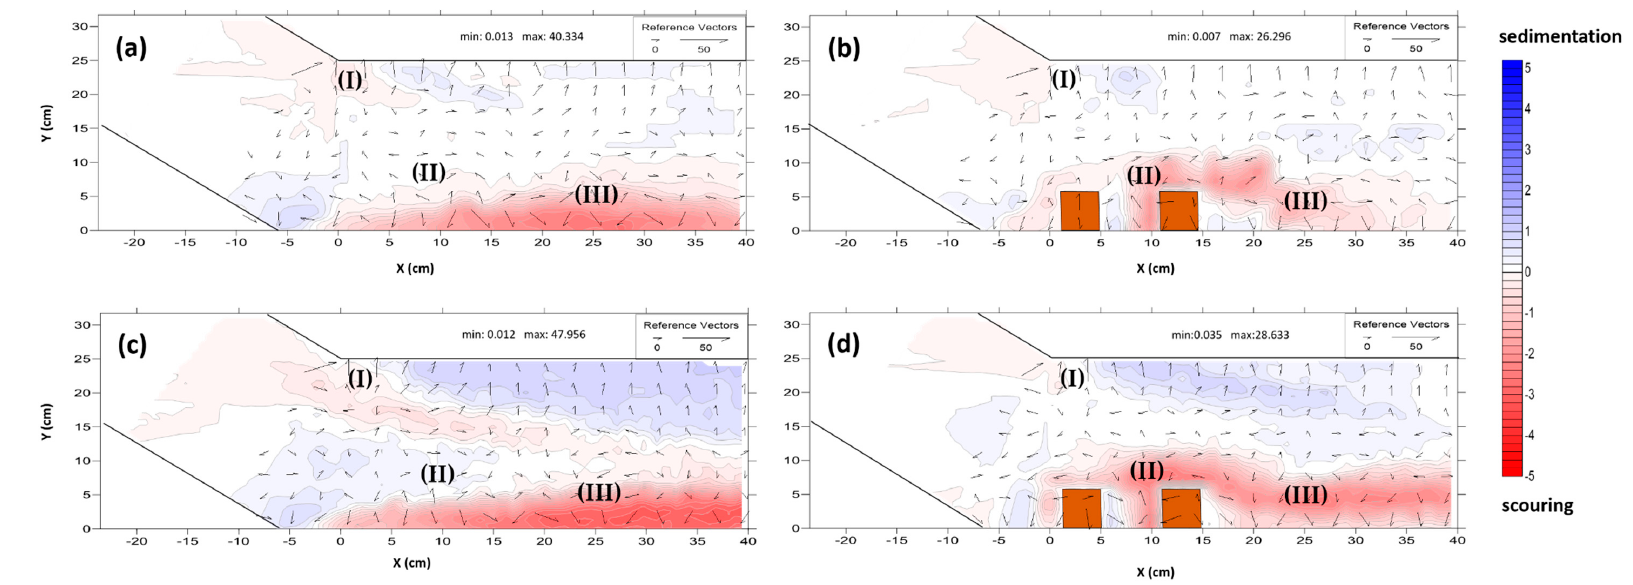
Figure 5. The scouring / sedimentation and velocity of ( a ) 10 years discharge period without spur protection, ( b ) 10 years with spur protection, ( c ) 20 years discharge period without spur protection and ( d ) 20 years discharge period with spur protection.